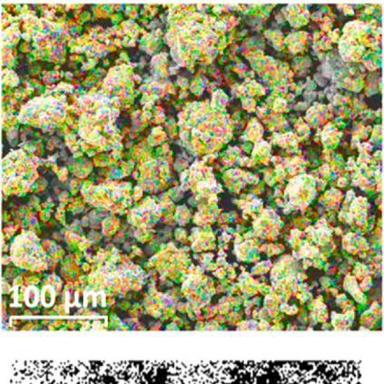
X-ray microanalysis of powders obtained by wet and dry milling: distribution maps of the Fe, Co, Nb, chemical elements on the starting sample (a) and the 5 h wet-milled sample (b) and 5 h dry-milled sample (c).